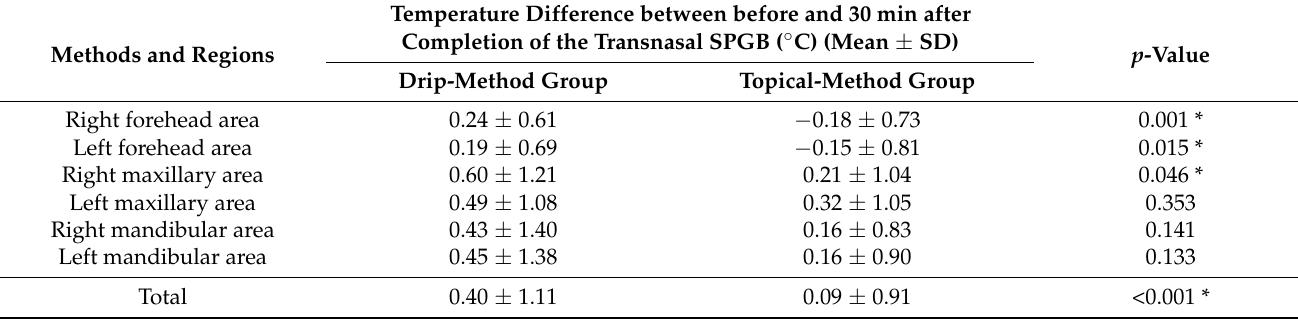
Table 4. Comparison between drip and topical